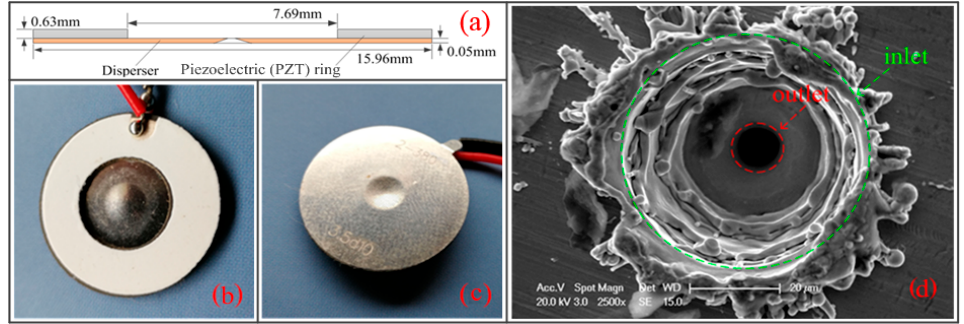
Figure 2. Atomizing film: ( a ) schematic diagram of the atomizing film structure; ( b ) front view of the atomizing film; ( c ) back view of the atomizing film; ( d ) image of the micro-cone hole aperture taken by the environmental scanning electron microscope.